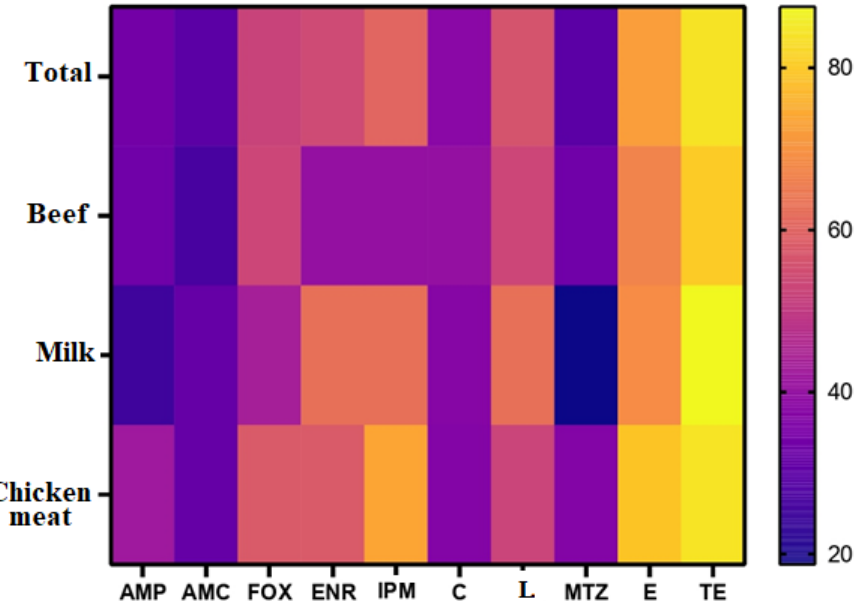
Figure 1. Frequency of resistance of C. perfringens isolates from beef, milk, and chicken meat samples to antimicrobials. AMP, ampicillin; AMC, amoxicillin/clavulanic acid; FOX, cefoxitin; ENR, enrofloxacin; IPM, imipenem; C, chloramphenicol; L, lincomycin; MTZ, metronidazole; E, erythromycin; TE, tetracycline. The percentages of resistance to antimicrobials are color-coded on the right of the figure.